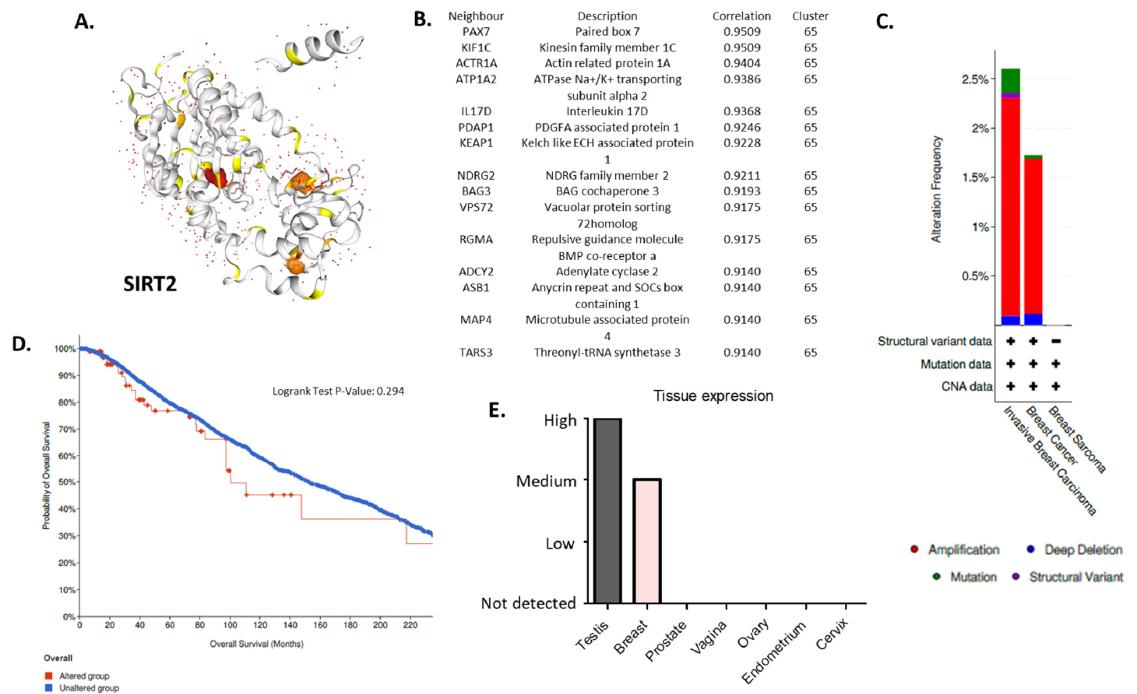
Figure 2. ( A ) Protein structure of SIRT2—NAD-dependent protein deacetylase which deacetylates internal lysines on histone and alpha-tubulin as well as other proteins such as key transcription factors (database: https://cancer.sanger.ac.uk/cosmic3d/protein/SIRT2?pdb=3ZGO, COSMIC database, accessed on 31 March 2022). ( B ) Fifteen nearest protein neighbors of SIRT2 based on tissue RNA expression; the correlation was calculated as Spearman’s correlation. The RNA data were used to cluster genes according to their expression across samples. The resulting clusters were manually annotated to describe the common features in terms of function and specificity. The annotation of the cluster is displayed together with the coincidence score of the gene’s assignment to the cluster. The coincidence is calculated as the fraction of the number of times the gene was assigned to this cluster in repeated calculations and is reported between 0 to 1, where 1 is the highest possible coinci- dence (Human Protein Atlas, accessed on 31 March 2022). ( C ) Differential alterations (amplification, mutations, deep deletions, structural variants) frequency observed in the SIRT2 gene in invasive breast carcinoma, breast cancer and breast sarcoma patients—data extracted from TCGA database (cBio database, accessed on 31 March 2022). ( D ) Kaplan–Meier plot: overall patient survival status. The plot indicates no different overall survival of BC patients that harbor at least one alteration in the SIRT2 gene (red) compared to patients without alterations (blue); 95% confidence interval is shown (cBio database, accessed on 31 March 2022). ( E ) IHC tissue expression of SIRT2 in the reproductive tract system (testes, breast, prostate, vagina, ovaries, endometrium, cervix) (Human Protein Atlas, accessed on 31 March 2022) ( E ). More details: https://cancer.sanger.ac.uk/cosmic, https://www.proteinatlas.org, http://www.cbioportal.org (accessed on 31 March